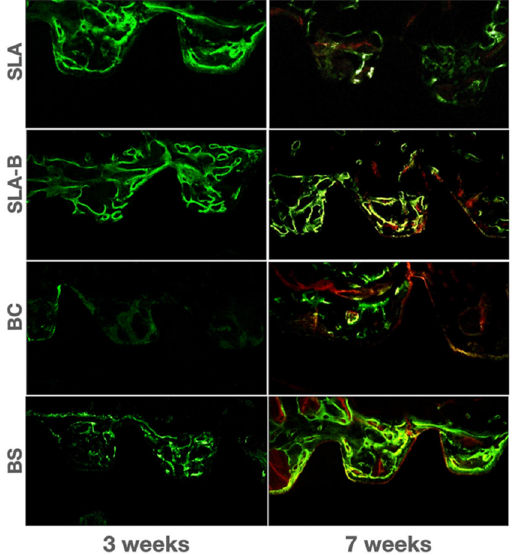
Figure 12. Fluorescence microscopic view of the bone deposition.